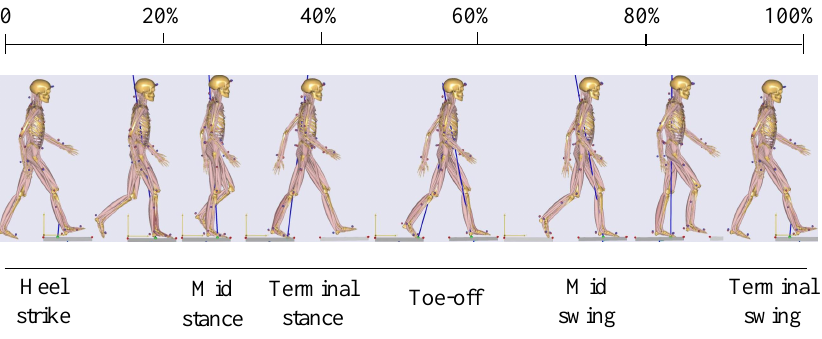
Figure 3. Human Gait Cycle